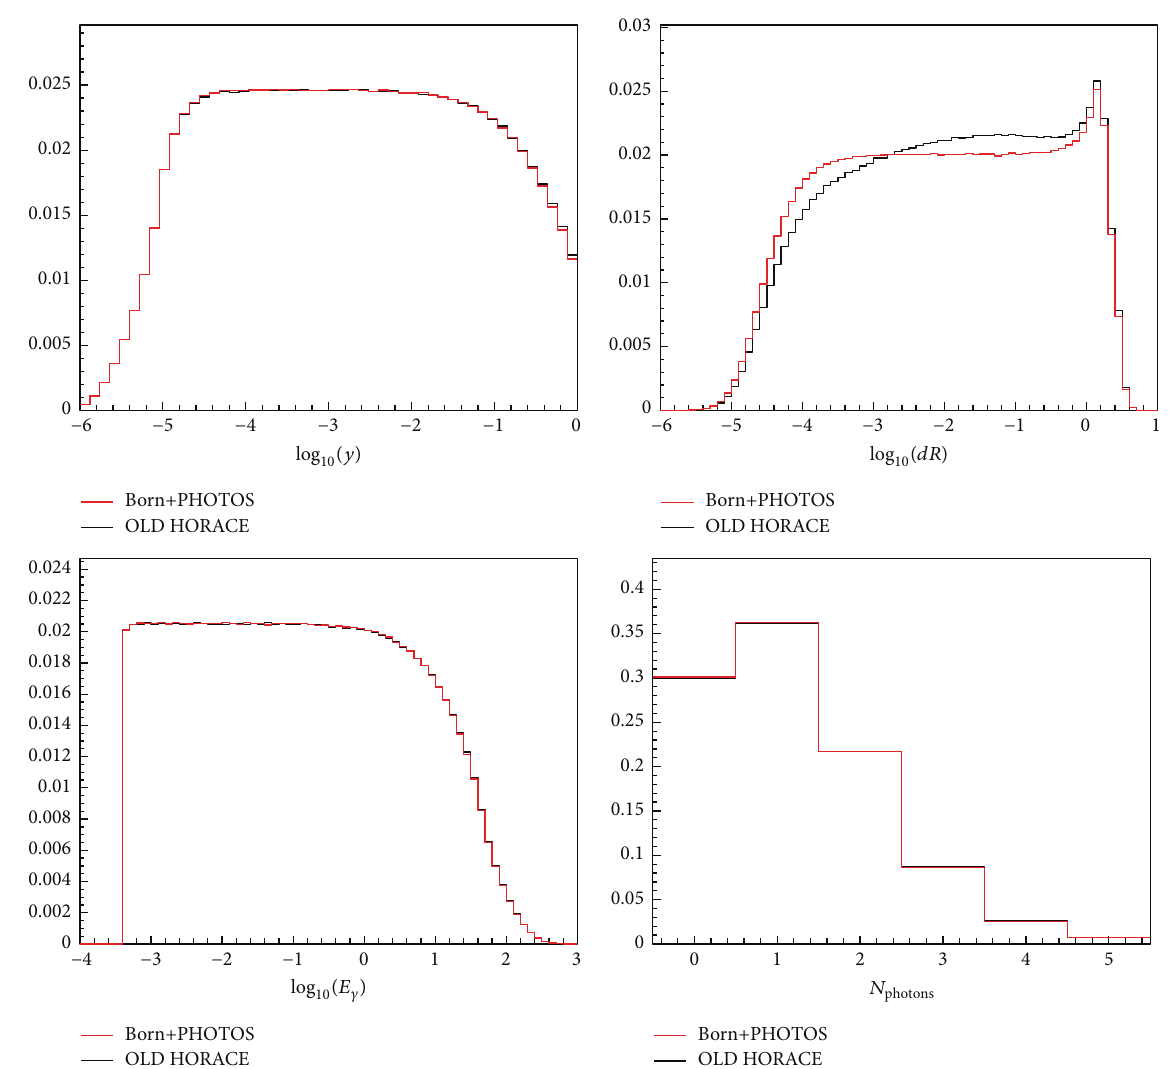
Figure 1: Clockwise from top-left: comparisons of the distributions of log 10 (𝑦 𝛾 ) , log 10 (Δ𝑅(𝑙𝛾)) , 𝑛 𝛾 , and log 10 (𝐸 𝛾 / GeV) for the 𝛾 ∗ /𝑍 → 𝑒 + 𝑒 − + 𝑛𝛾 process between the “Born” mode of old horace interfaced with photos and old horace in the exponentiation mode. The smaller of the two Δ𝑅 values with respect to the two electrons is